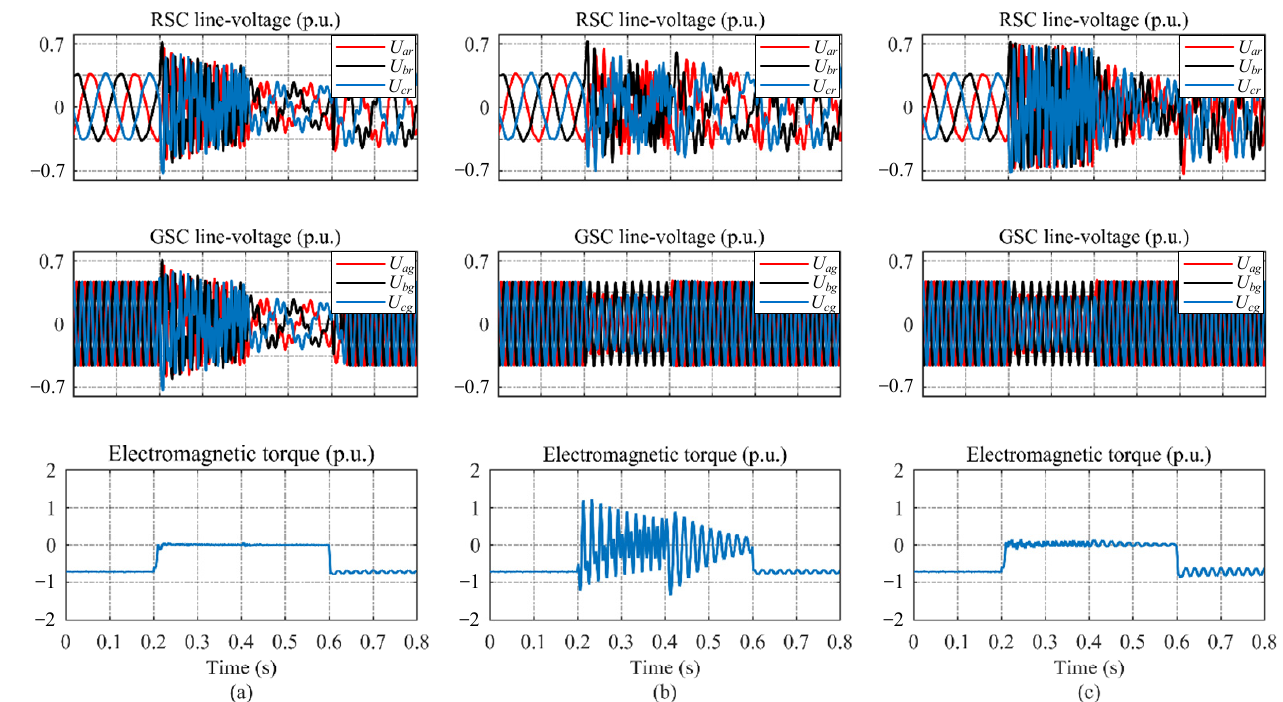
Figure 13. Simulation results of single-phase grid voltage sag of 80%. ( a ) DISC. ( b ) Method-1. ( c ) Method-2.